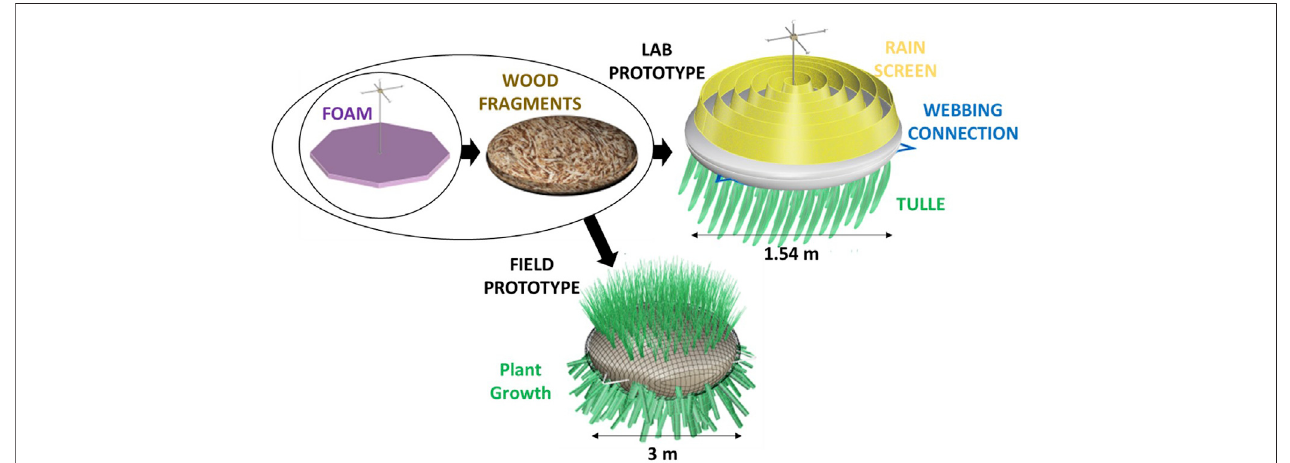
FIGURE 3 | Flow chart of the components of the wave basin prototype and the fi eld prototype. Both contain foam (purple) and wood fragments from local forestry services (brown), but the Field Prototype (bottom) is made from burlap and coconut fi ber to encourage natural plant growth (e.g., Spartina ) while the Lab Prototype (top right) is made from lightweight canvas, a rain screen sewn to the top (yellow), strands of tulle sewn to the bottom (green), and webbing also sewn to the bottom in a triangle with the corners stick out (blue) to provide connection points to other mats and basin anchors.